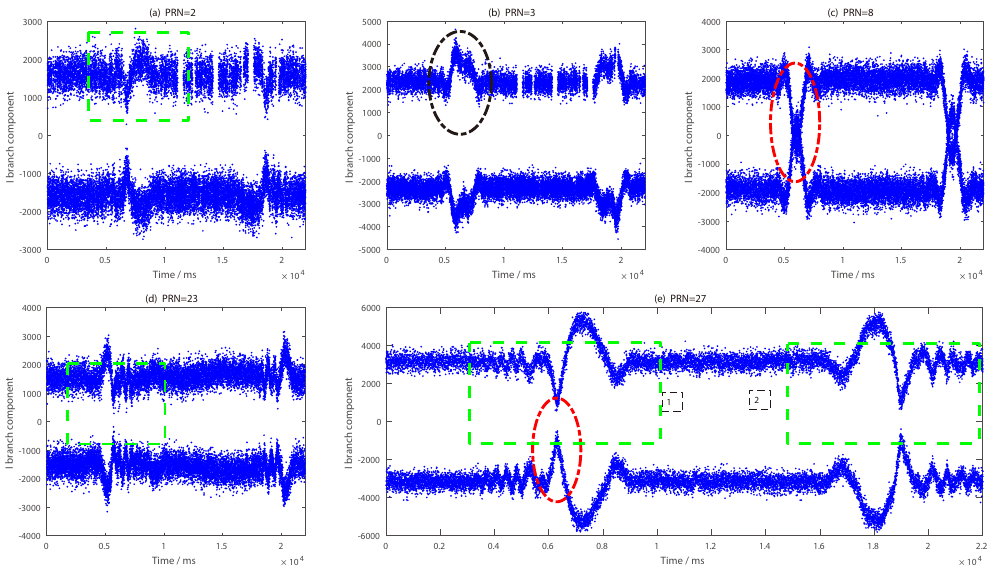
Figure 22. I branch component of five BeiDou satellite reflected signals: ( a ) PRN2 satellite; ( b ) PRN3 satellite; ( c ) PRN8 satellite; ( d ) PRN23 satellite; ( e ) PRN27